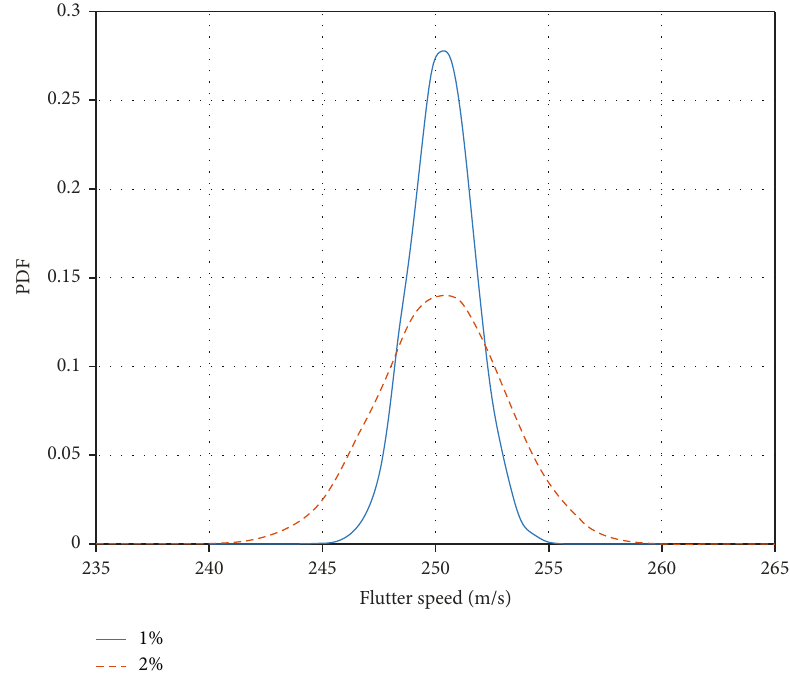
Figure 17: PDF of fl utter speed: deviation in the mode frequency.